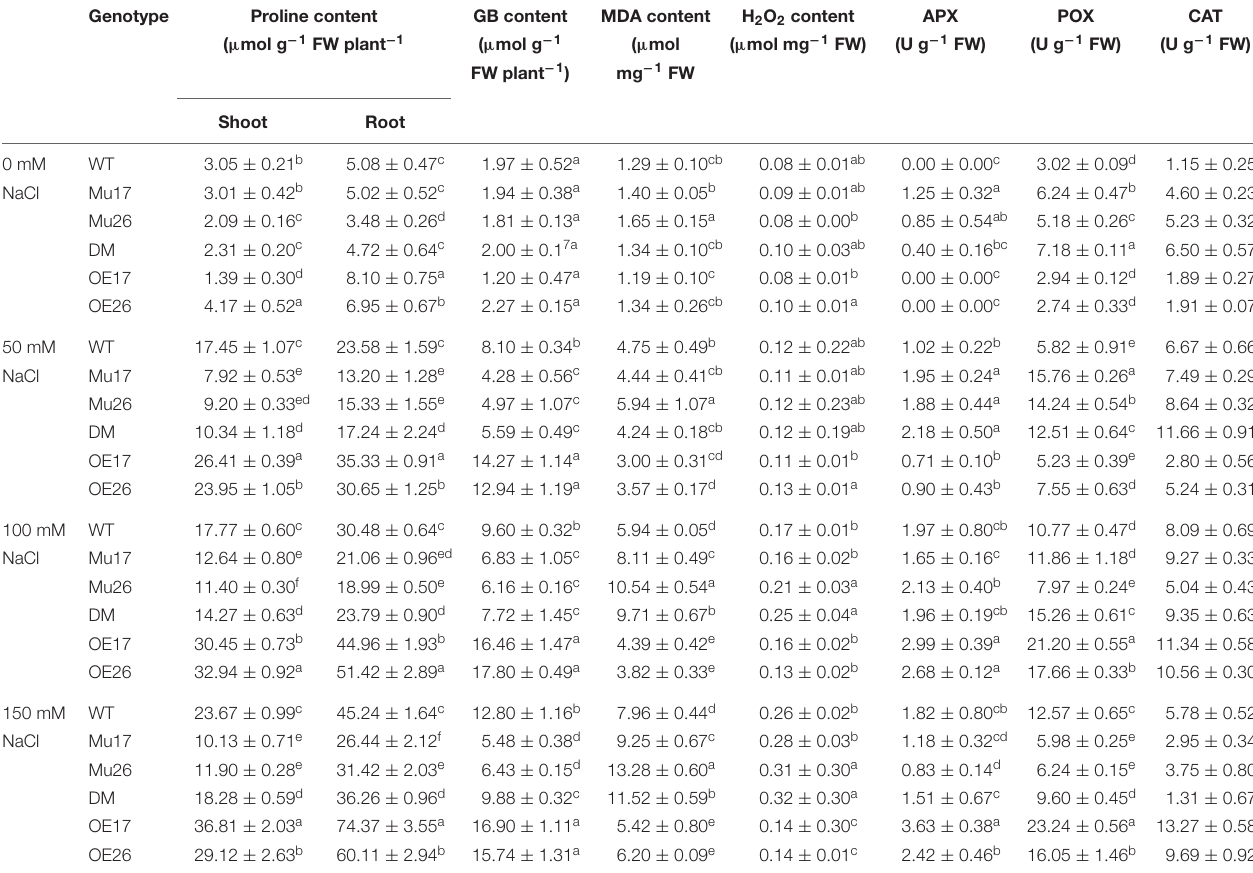
TABLE 3 | Means ( ± SE) of the physiological and biochemical parameters in genotypes subjected to the NaCl concentrations. Genotype Proline content GB